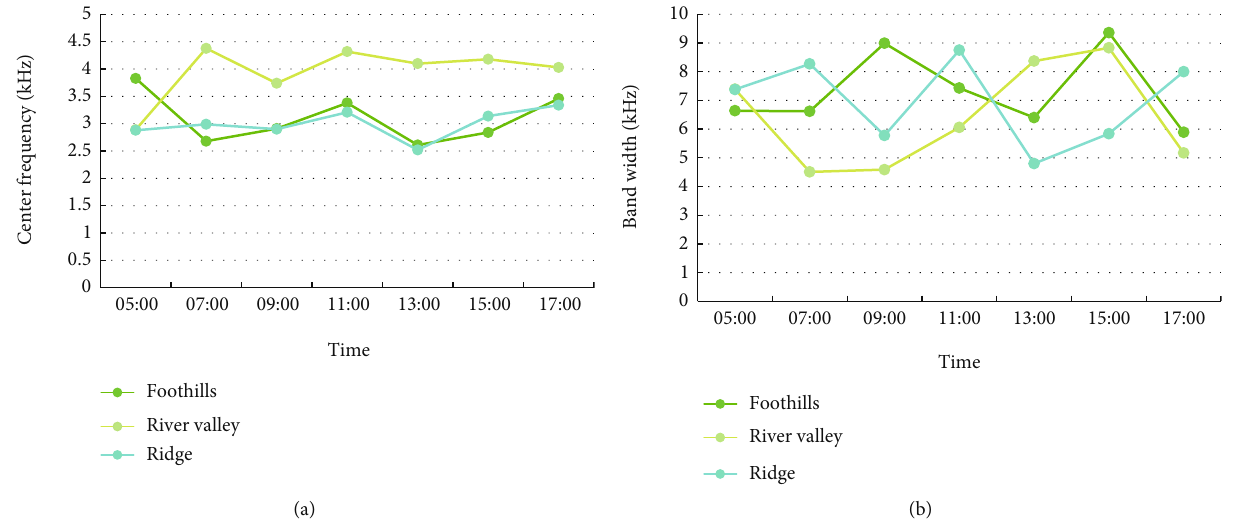
Figure 9: Daily changes of birdsong (a). Daily variation of bird song center frequency (b) day variation, bird ’ s song frequency